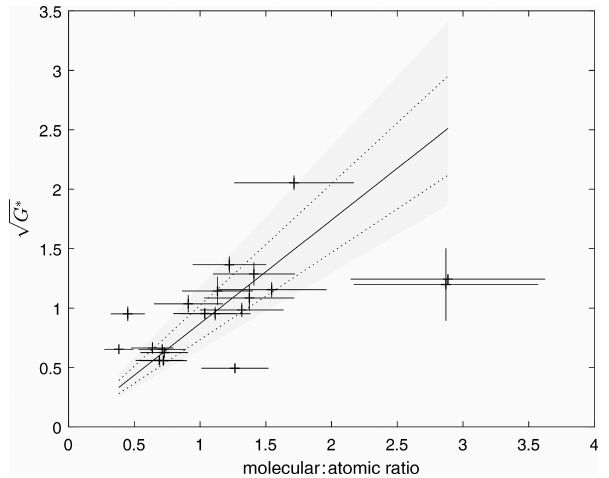
Figure 6. The same as for Fig. 5 but with the alternate parameter G ∗ now used in the analysis, after King (1969). Once again, heights of the F1 peak were determined from the ionogram inversion algo- rithm ARTIST. The resulting fit yields a gradient of 0 . 86 ± 0 . 14.